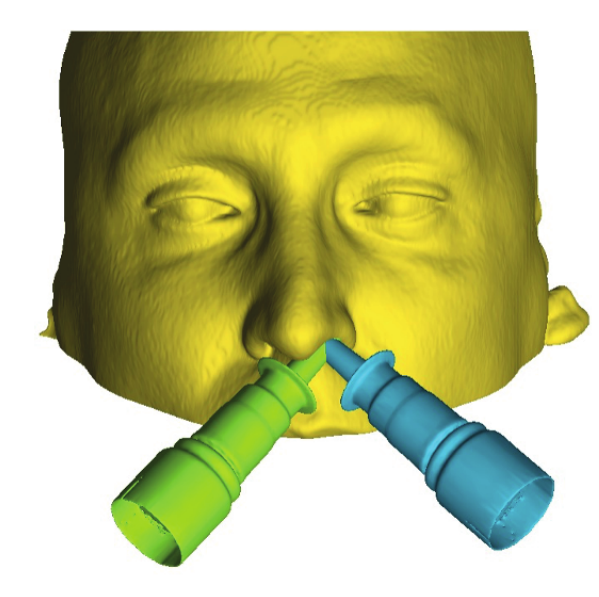
Figure 4. Range of Septal Angles. This figure demonstrates the wide range of angles at which patients sprayed INCS. The angles ranged from 500 to the septum to 420 degrees to the lateral